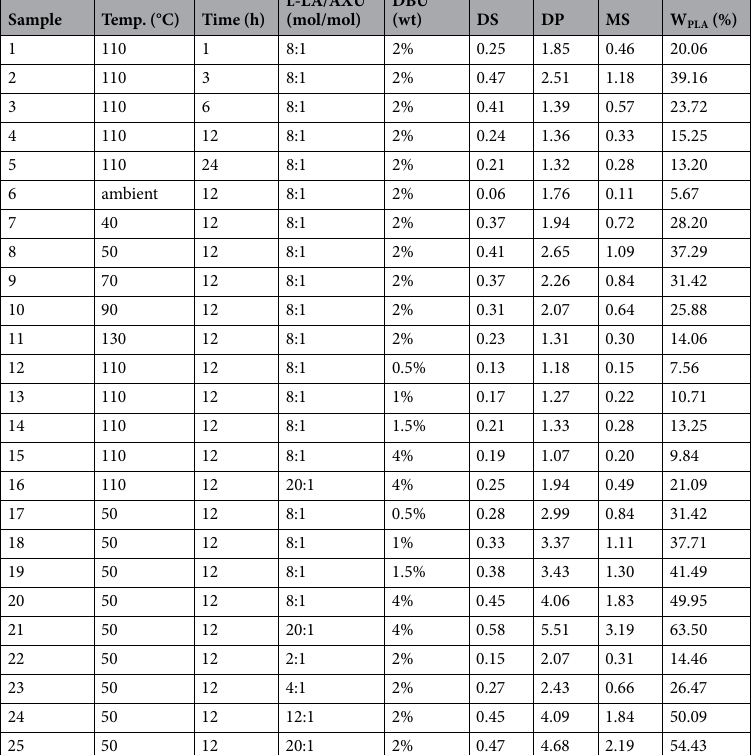
Table 1. Compositional reaction parameters of xylan- g -PLA copolymers synthesized under different reaction conditions. (DS, the degree of substitution of xylan- g -PLA copolymers, calculated by 1 H-NMR; DP, the degree of polymerization of PLA side chains, calculated by 1 H-NMR; MS, the molar substitution of xylan- g -PLA copolymers, calculated by 1 H-NMR; and W PLA , the weight content of PLA side chains, calculated by 1